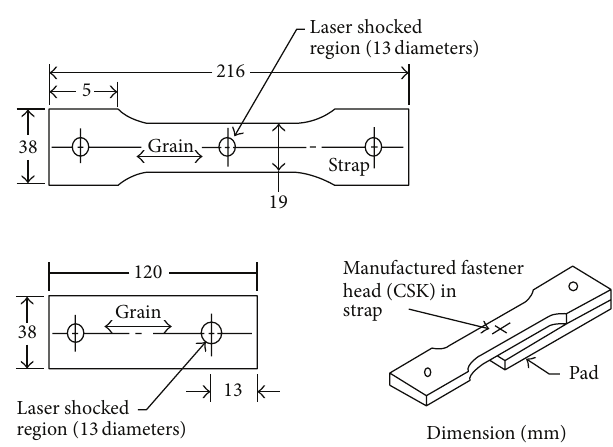
Figure 13: Ferreting fatigue specimen configuration [62].